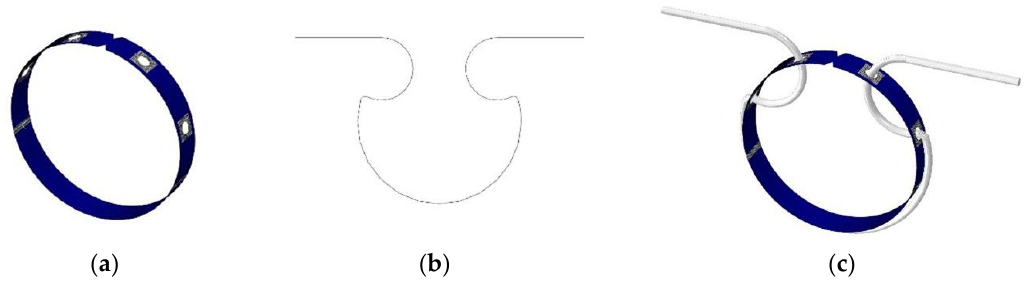
Figure 6. Three-dimensional numerical modeling of the system components, ( a ) steel ring model; ( b ) wire rope model; and ( c ) the assembled model.